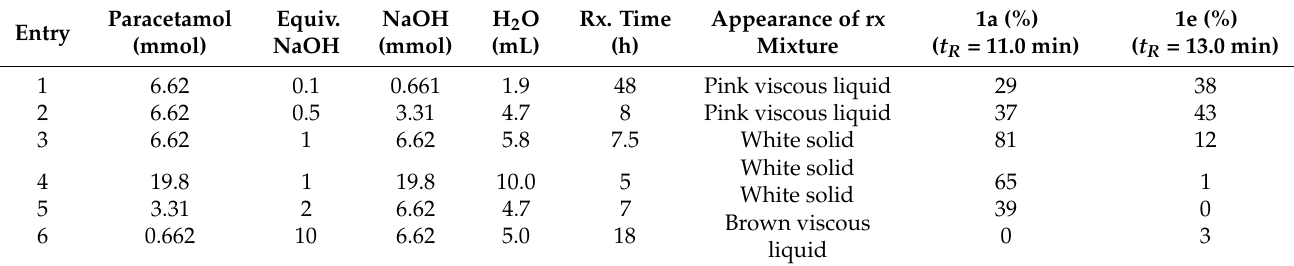
Table 2. Synthesis of N -(4-(oxiran-2-ylmethoxy)phenyl)acetamide, 1a , and N-(4-(3-chloro-2-hydroxypropoxy)phenyl)acetamide, 1e , from paracetamol, 1 , with epichlorohydrin and NaOH at room temperature The table shows reaction conditions, equivalents and starting amounts of base (mmol), and the ratio of 1a and 1e in the product mixture, calculated from HPLC chromatograms on Eclipse XDB-C18-column and gradient program (H 2 O:MeCN 90:10-H 2 O:MeCN 75:25 over 20 min, 0.5 mL/min flow). Paracetamol Entry (mmol)